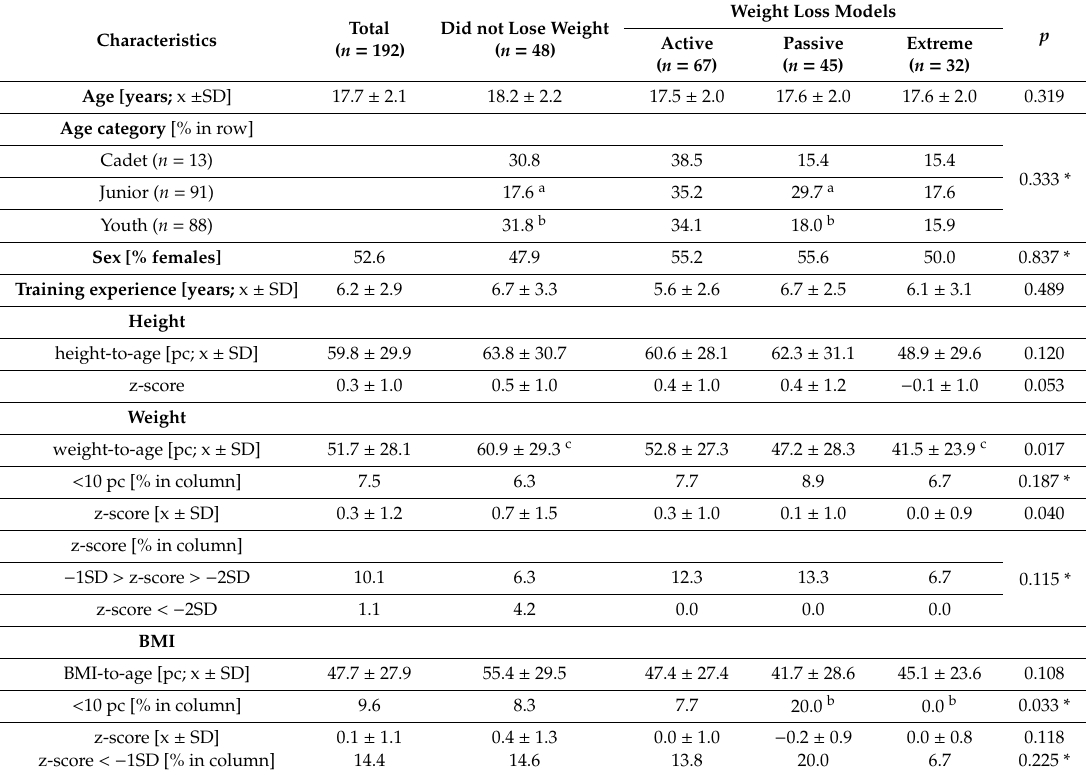
Table 4. Athletes’ characteristics in di ff erent weight management